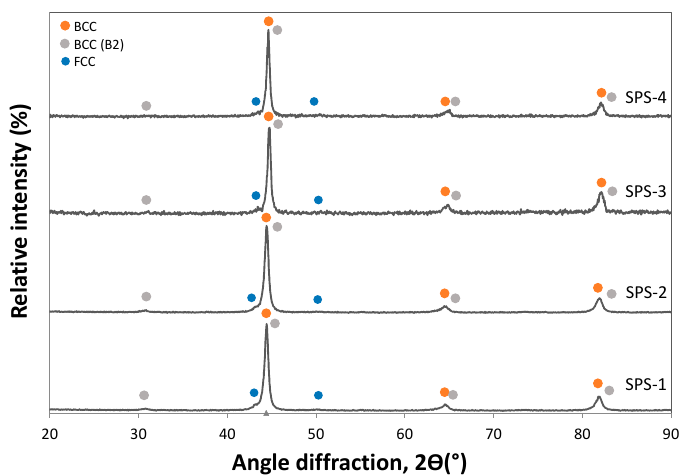
Figure 6. XRD analysis of samples sintered by SPS.